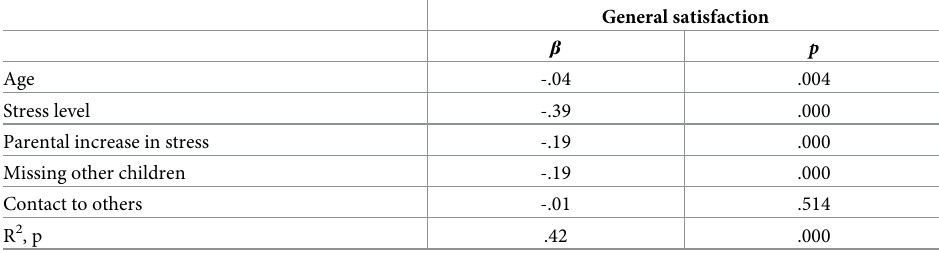
Table 3. Linear regressions on children’s general